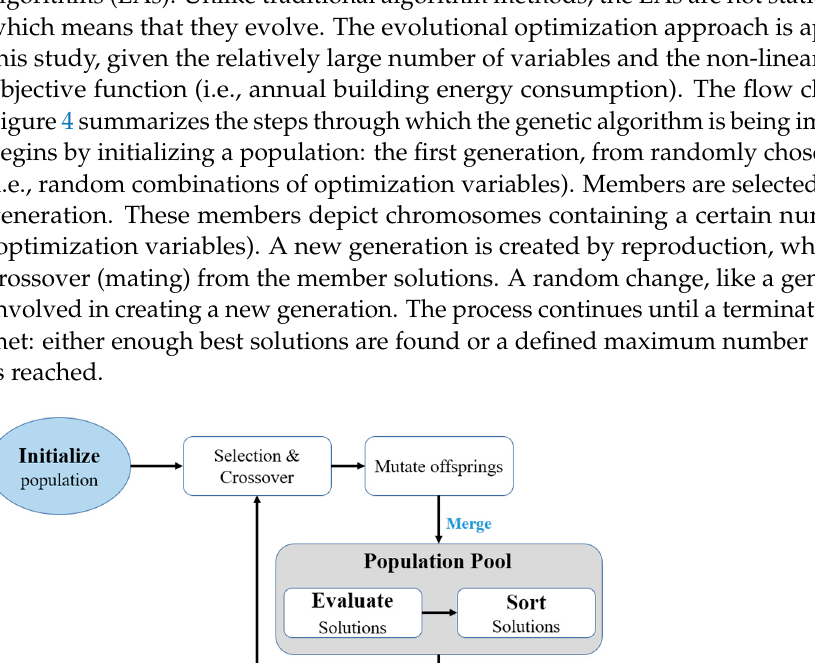
8 of 16 Table 3. Optimization variables and ranges. Variable Minimum Maximum X 1 = Wall R-value